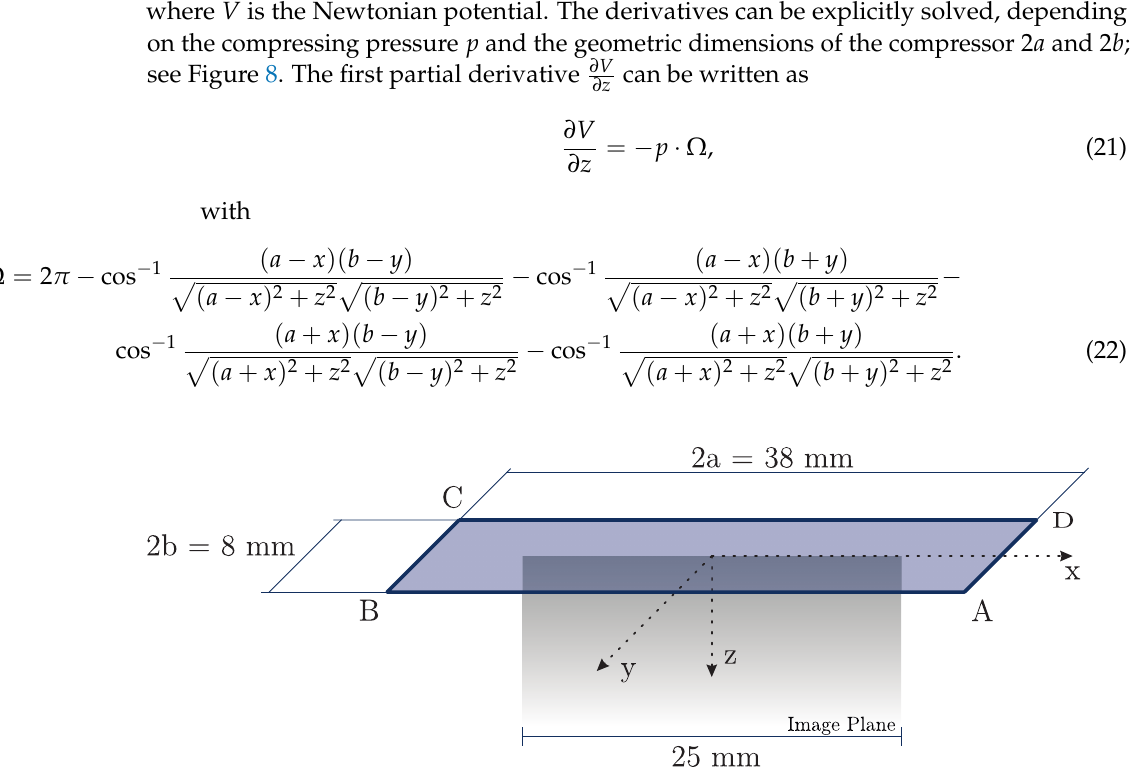
Figure 8. The geometric principal points and the coordinate system for the stress computation. The constant pressure p is applied on the area ABCD in positive z -direction. In this figure, the contact area of the US transducer with the appropriate dimensions (38mm × 8mm) is shown. Therefore, the compressing surface is smaller than the top area of the specimen (45mm × 25mm). Additionally, the image plane is